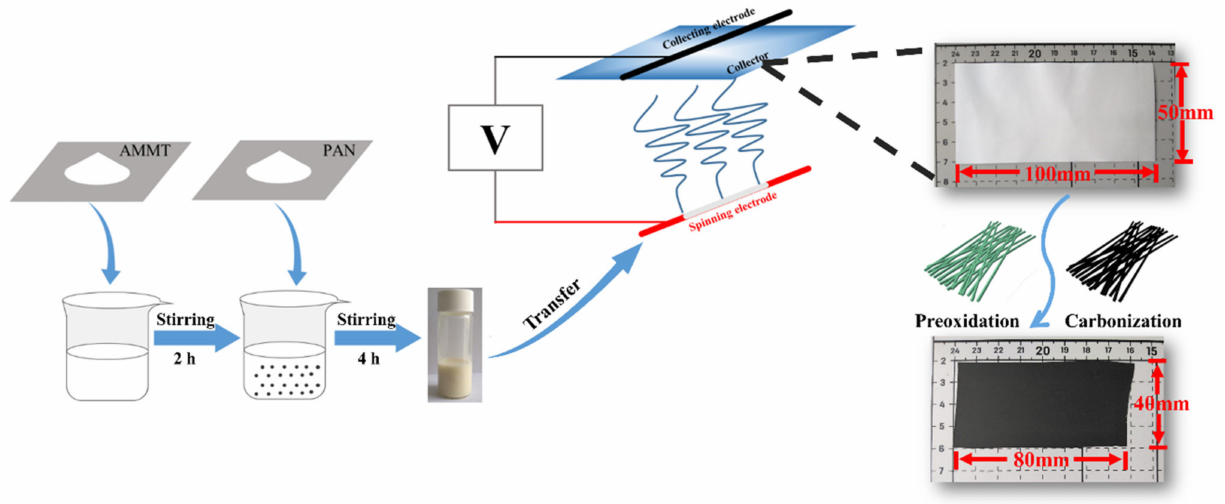
Figure 1. Schematic diagram of the preparation of self-supporting MoO 2 /carbon nanofiber